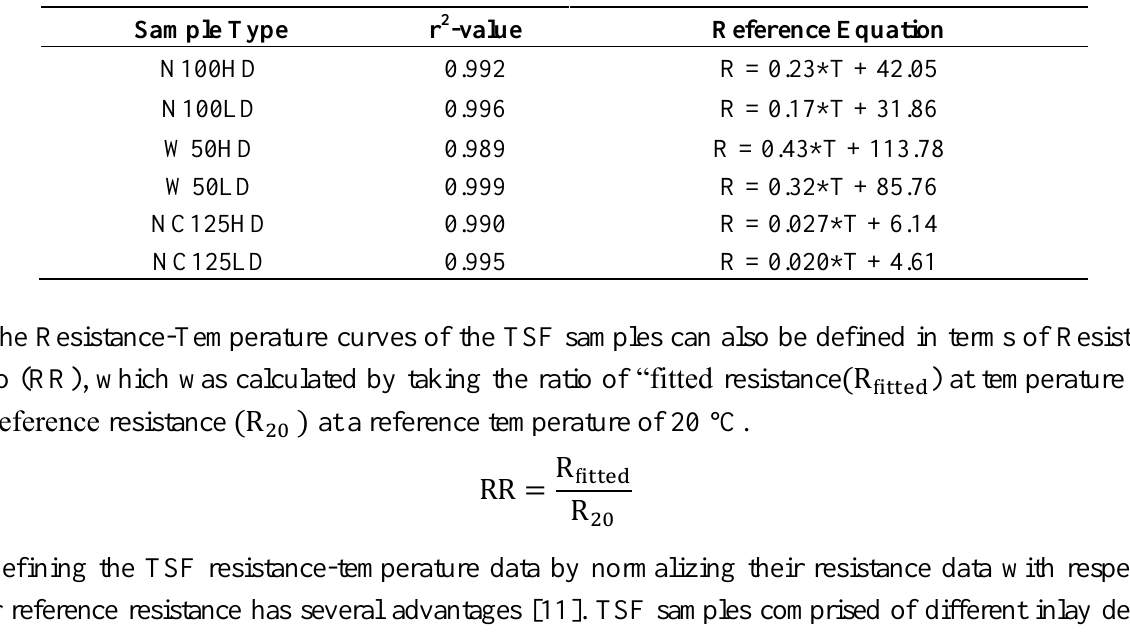
Table 3. Coefficient of determination and reference equation of each sample category.